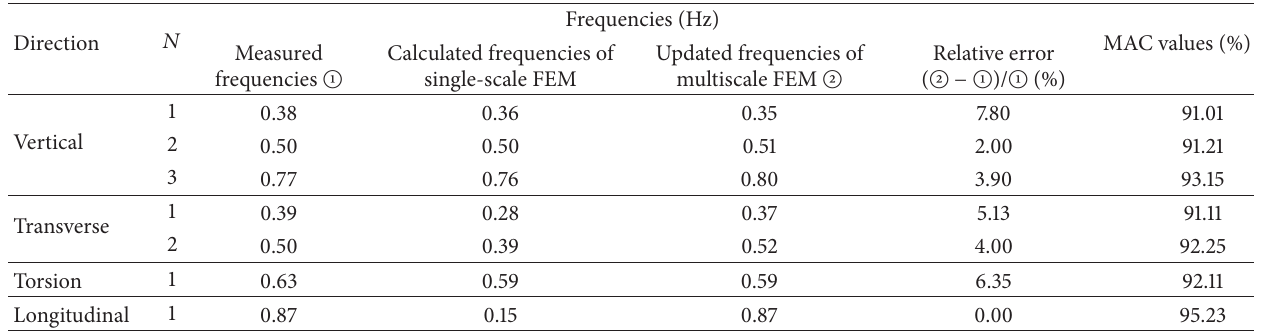
Table 9: Comparison of updated frequencies and measured frequencies, MAC values (unit: Hz).